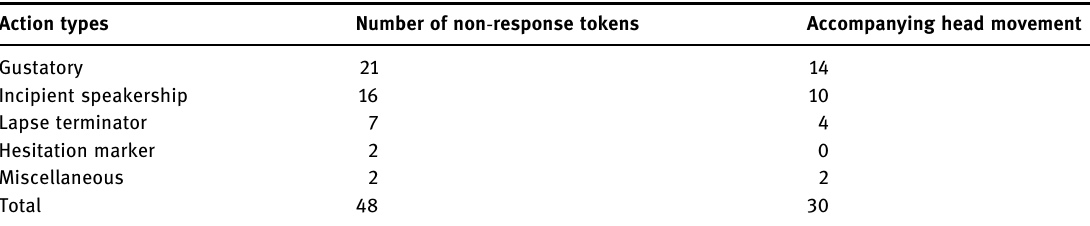
Table 3: Action - type classi fi cation for “ mm ” as a non - response token Action